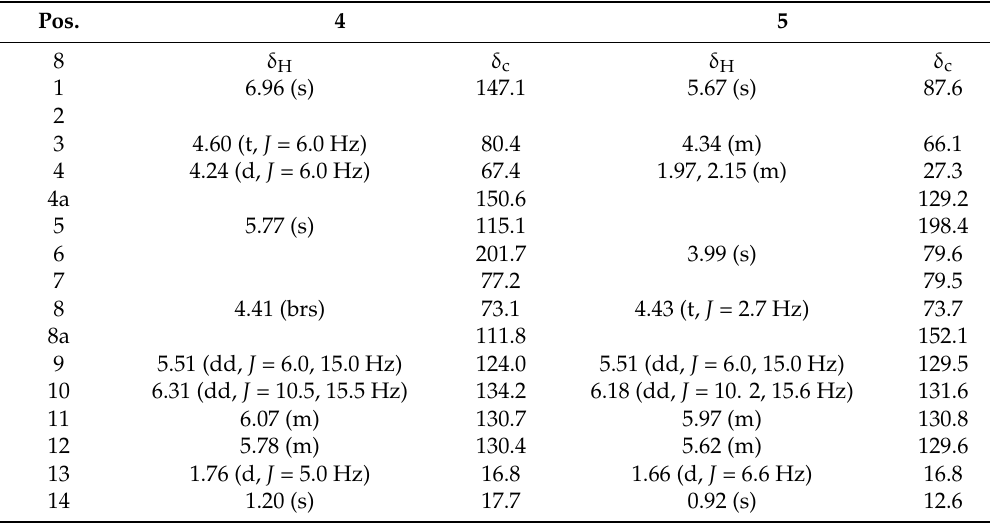
Table 2. 13 C NMR and 1 H NMR data of compounds 4 and 5